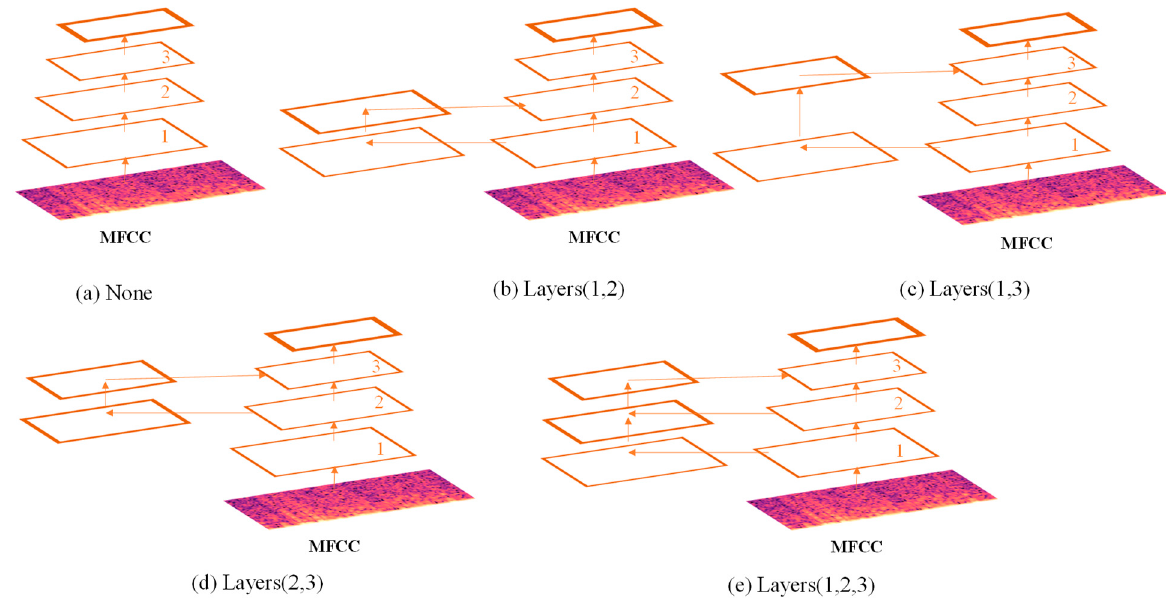
Figure 7. Schematic diagrams of different multi-scale structures.